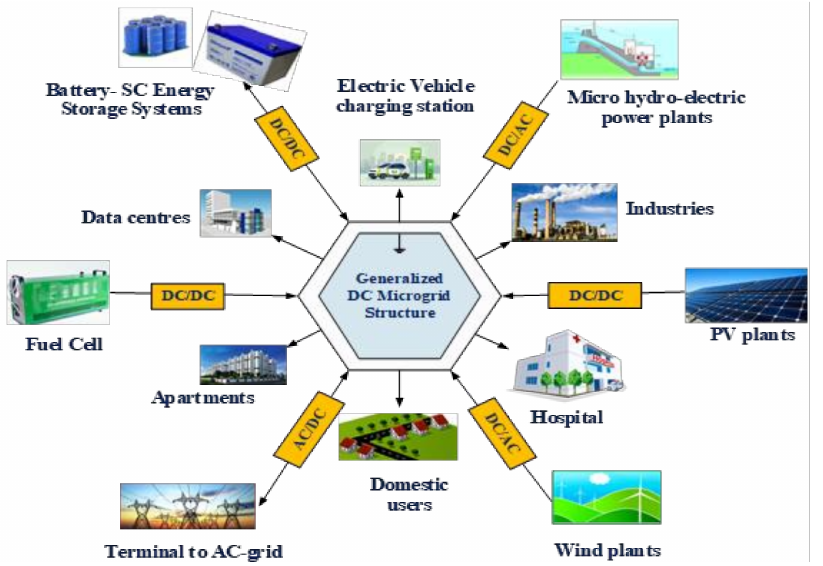
Figure 1. DC microgrid